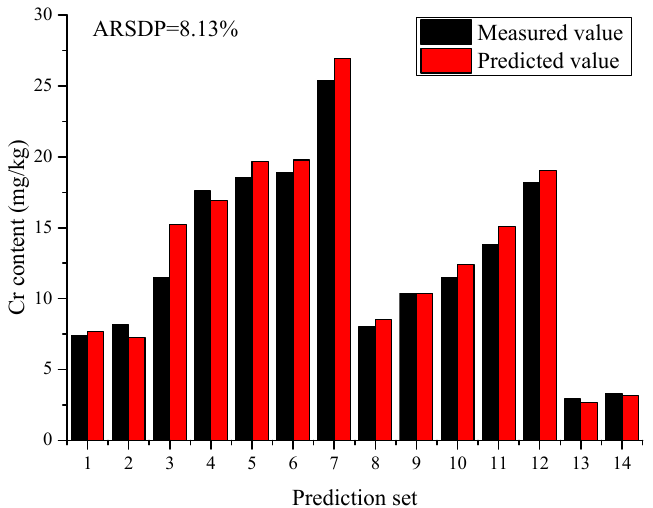
Figure 4. Prediction results of the 3 classification regression model.